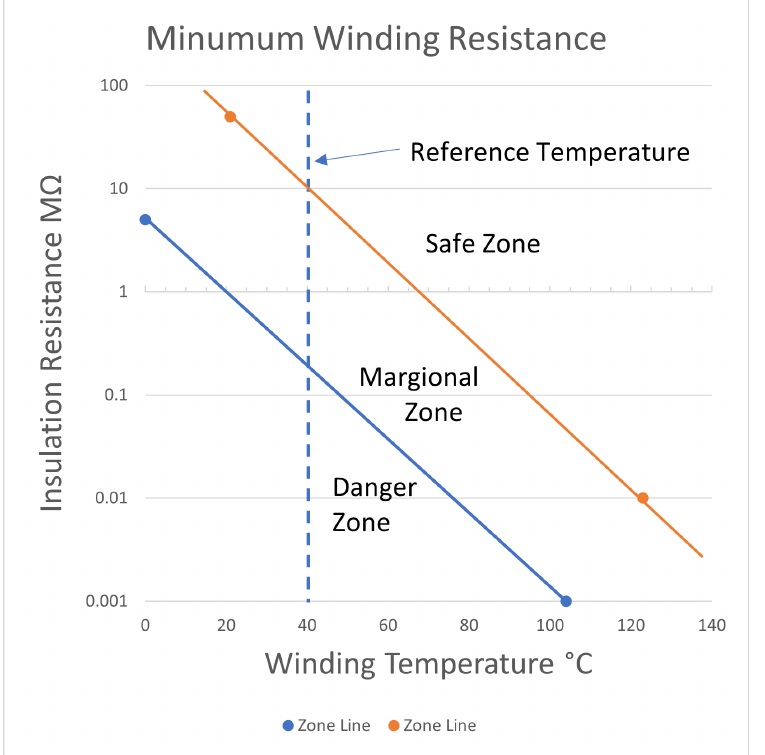
Figure 4. Insulation resistance measurement guide for low voltage motors (adapted from